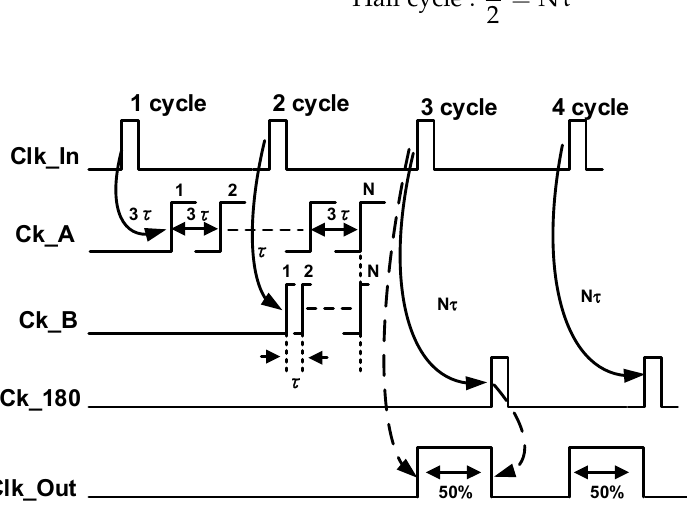
Figure 1. Concept diagram of proposed circuit.